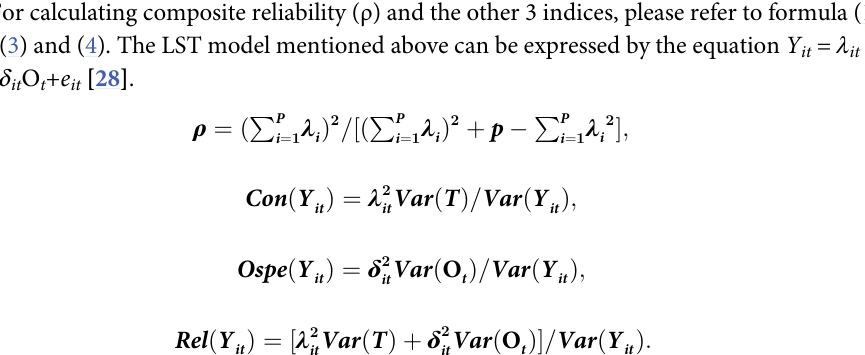
because the latent state-trait theory/model (LST) allows us to “examine” the effects of traits, sit- uations, and their interactions at the same time, it and its 3 indexes ( Con , Ospe and RC ) were used to evaluate the scale’s retest performance. More importantly, for constructs that were strongly situation-dependent, showing high occasion specificities, high test–retest correlations could not be expected (and might not be appropriate). In contrast, the measures for reliability based on LST can still be perfectly reliable [26]. The In test-retest reliability analysis (based on third round testing and fourth round testing), the reliability indicators based on CTT and LST were both provided by us [27], and a comparison was additionally made between the 2 Con stands for consistency, reflecting the ratio of observed variance determined by traits. Ospe denotes occasion-specificity, representing the ratio of observed variance determined by situa- tions and their interactions. Finally, RC indicates the reliability coefficient, the sum of Con and Ospe .